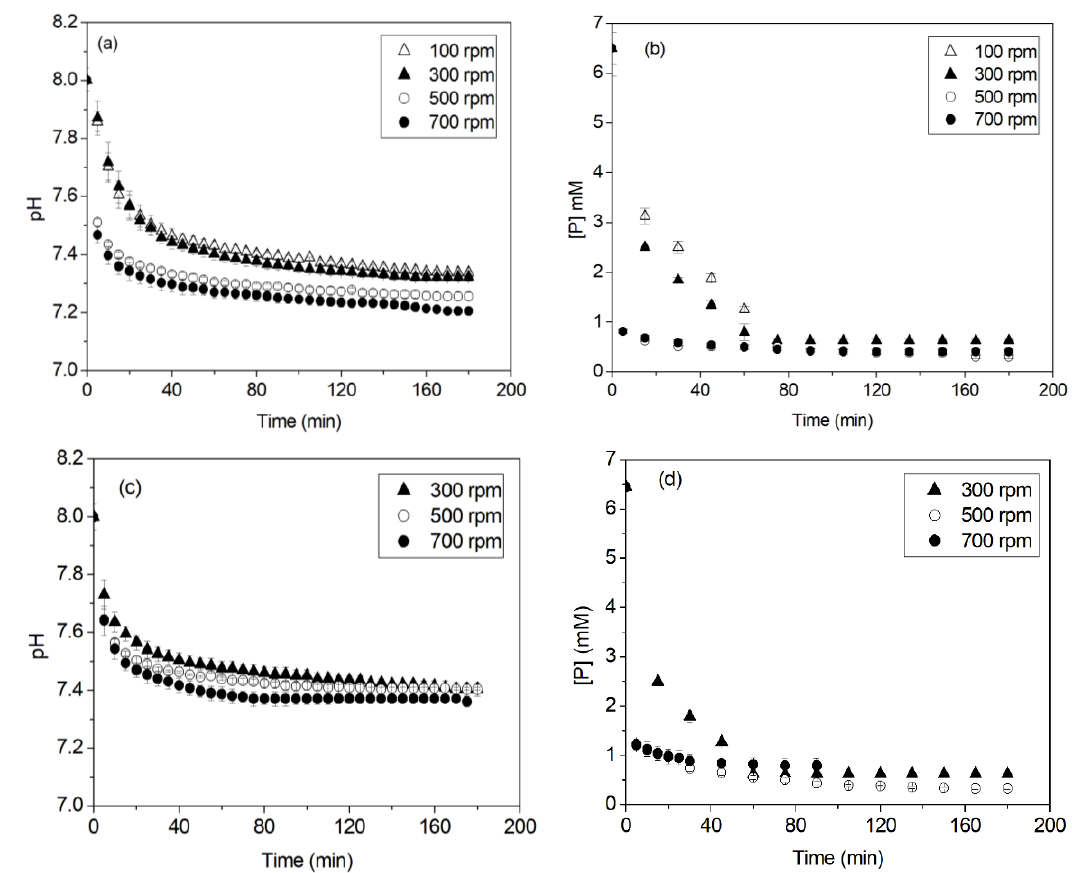
Figure 3. Variations of pH and phosphorus concentration over time for different stirring rates, an initial phosphorus concentration of 200 mg · L − 1 and solution volumes of ( a , b ) 600 mL and ( c , d ) 1200 mL.